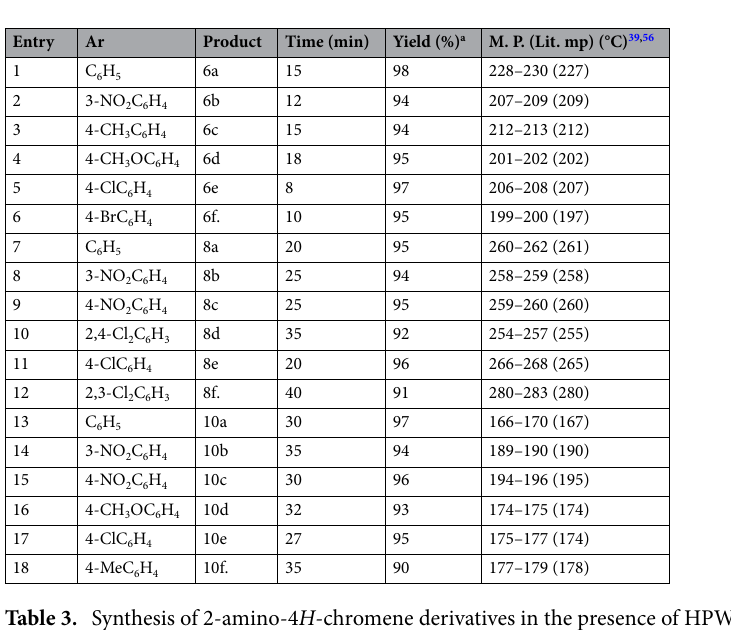
Table 3. Synthesis of 2-amino-4 H -chromene derivatives in the presence of HPW@Fe 3 O 4 –Al 2 O 3 –CS–CG.